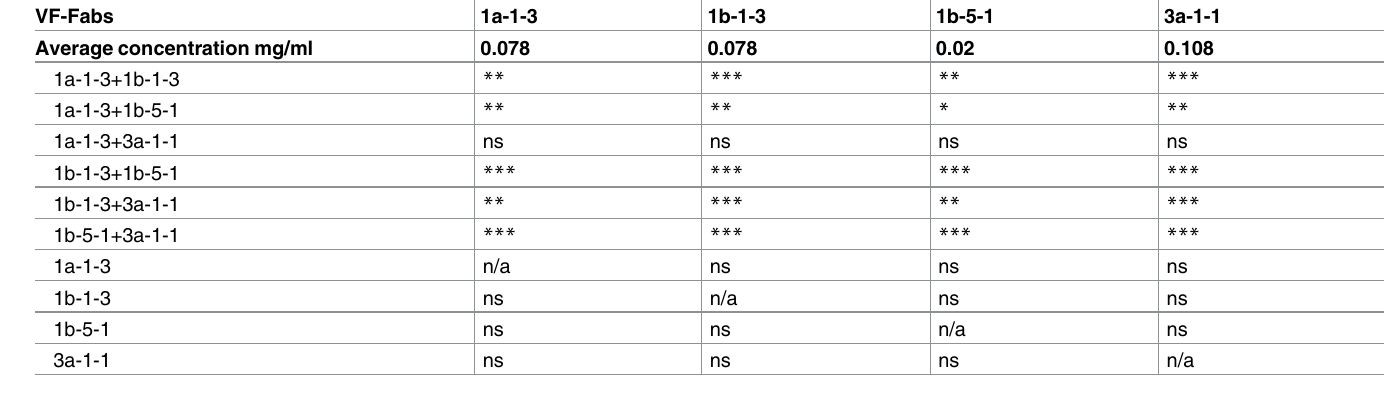
Table 5. Summaryof statistical significance of averageIC 50 (mg/ml) of VF-Fab in combination in comparison with the individual VF-Fab.